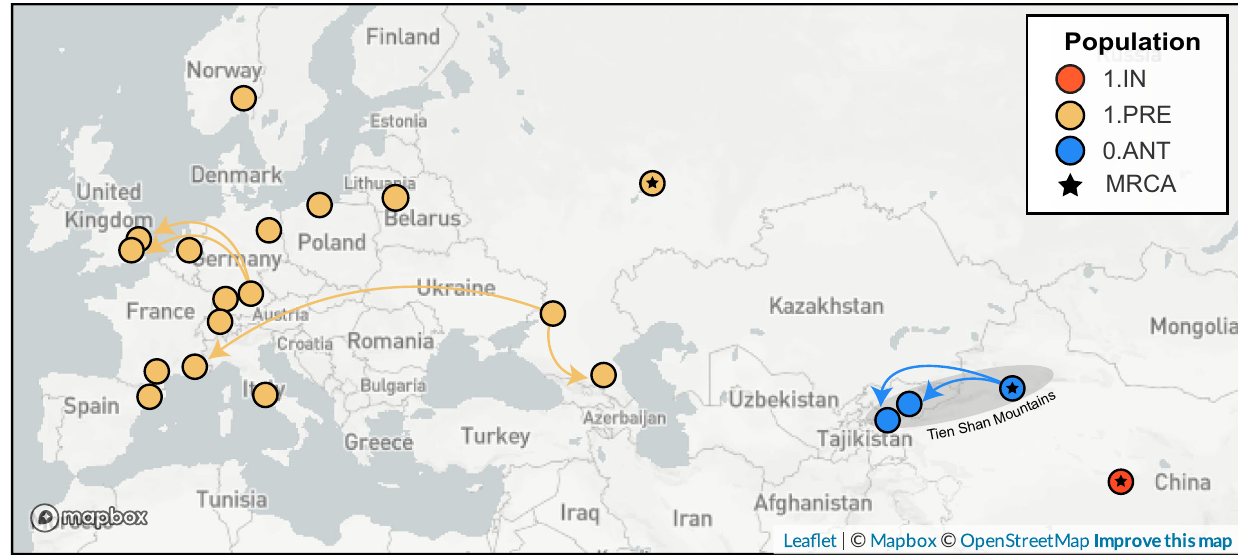
Fig. 7 Geographic origins and spread of the Second Pandemic (1.PRE), the ancestral Antiqua (0.ANT) and descendant Intermedium (1.IN) populations. Ancestral locations were estimated by fi tting a discrete mugration model to the maximum likelihood phylogeny using sampling locations by province. Arrows re fl ect the directionality of spread, but not the precise route taken, for high-con fi dence migrations estimated with an ancestral likelihood greater than or equal to 0.95 and a branch support bootstrap of greater than or equal to